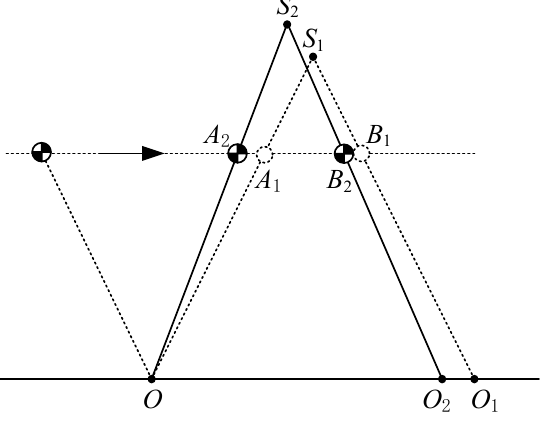
Figure 11. Trajectory planning for unexpected landing time or foot placement.